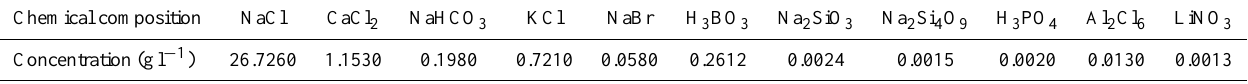
Table 1. Chemical composition of magnesium-free, artificial seawater. Chemical